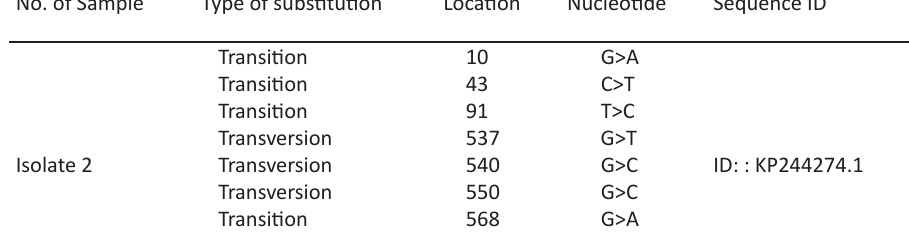
Table 2. Represent type of polymorphism of 16S rRNAgene from E. coli isolate No. of Sample